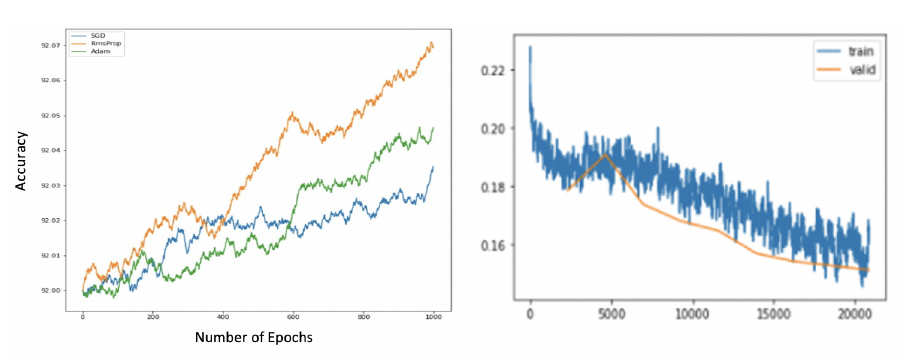
Figure 4. The accuracy of ResNet.